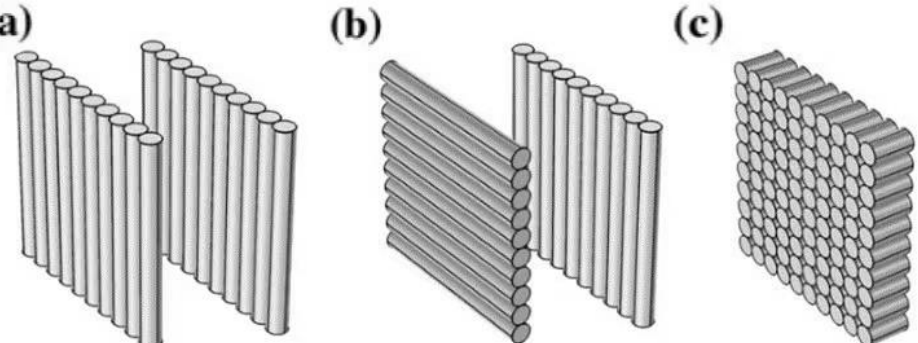
Figure 15. Different arrangement directions of fibers. ( a ) pattern 1 with films overlapped along the same direction; ( b ) pattern 2 with films overlapped and rotated by 90 ◦ ; ( c ) pattern 3 with fiber oriented to the out-panel direction. ( a – c ) Adapted with permission [95], Copyright 2019, Applied Thermal Engineering.